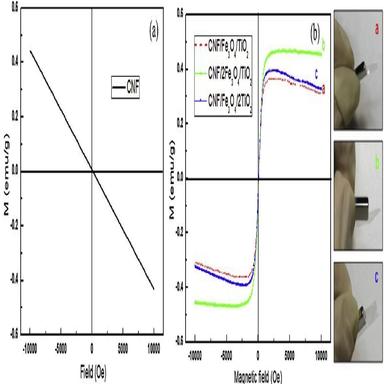
Magnetic curves of (a) CNF and (b) CNF hybrid nanocomposites with different contents. The photos on the right side of the (b) shows that 15\5 mm2 strip magnetic nanopapers can be easily lifted with a household magnet.